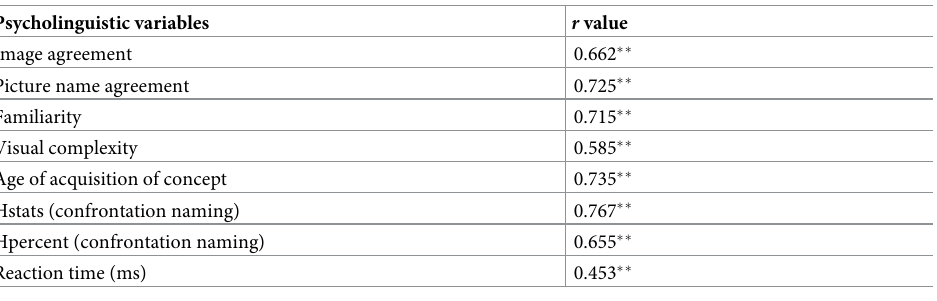
Table 3. Correlations between younger and older